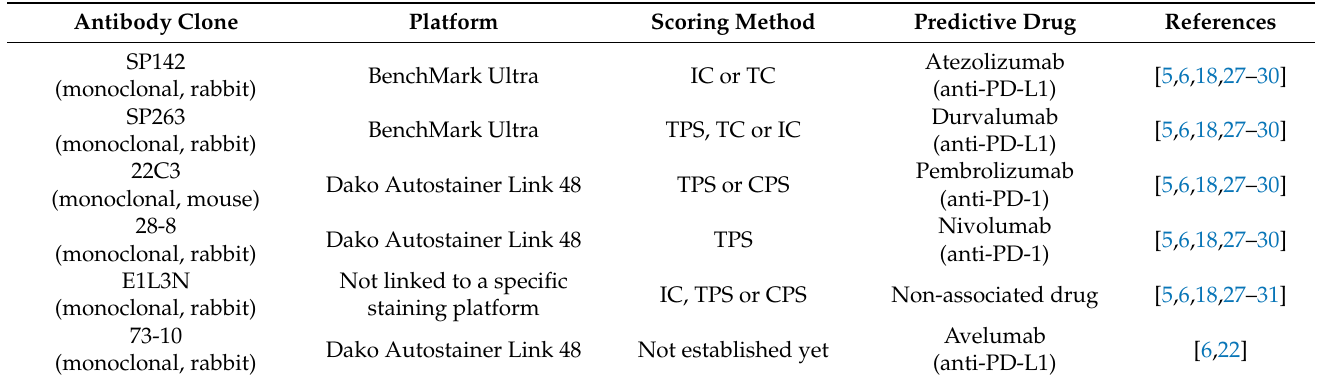
Table 2. Most commonly used IHC assays in malignant tumors with the scoring methods and predictive